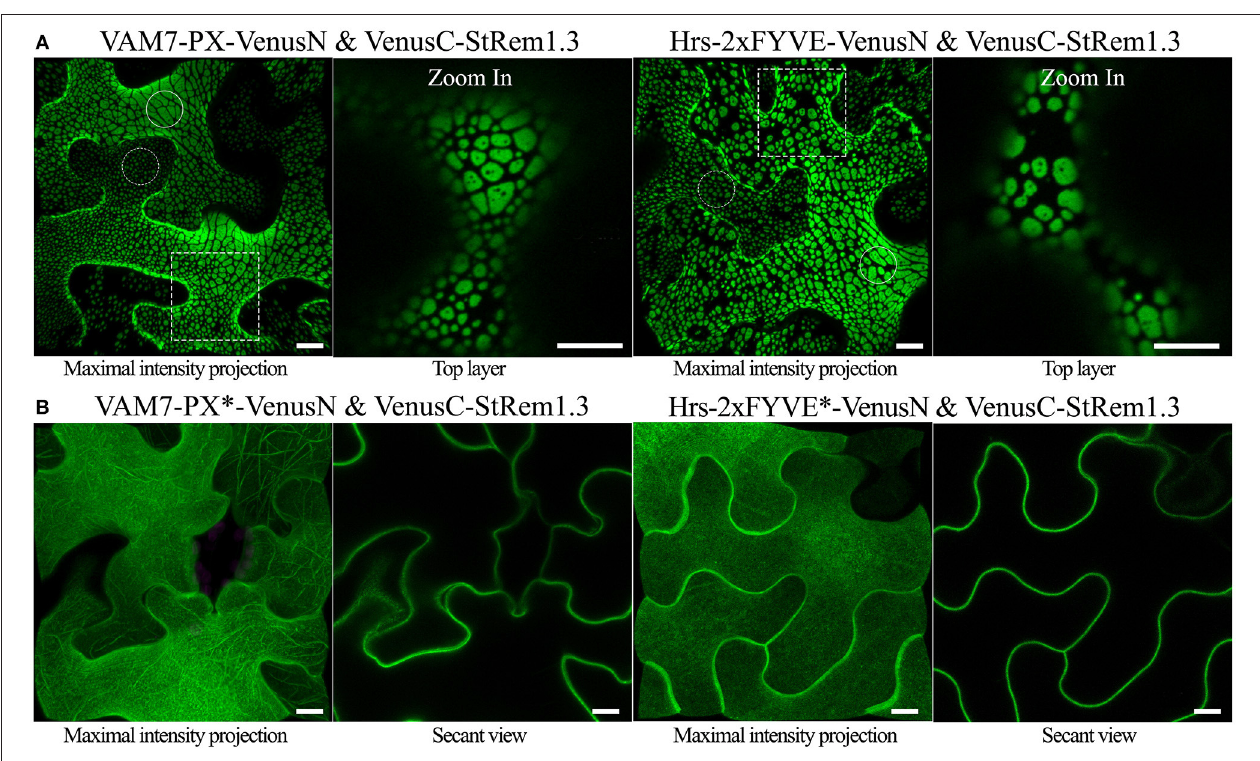
FIGURE 1 | Co-expression of PtdIns(3)P-binding proteins and StRem1.3 produces BiFC complexes distributed in large patches on the PM of N. benthamiana leaf cortical cells. (A) BiFC fluorescence in cells co-expressing VAM7-PX-VenusN or Hrs-2xFYVE-VenusN with VenusC-StRem1.3. The dotted boxes indicate the regions zoomed in in the top layer projections. (B) BiFC fluorescence in cells co-expressing VenusC-StRem1.3 with VenusN fusions to the PtdIns(3)P-non-binding mutants, VAM7-PX*, Hrs-2xFYVE*. Large membrane patches are highlighted by the solid circles, and small punctae are highlighted with the dotted circles.All scale bars represent 10 µ